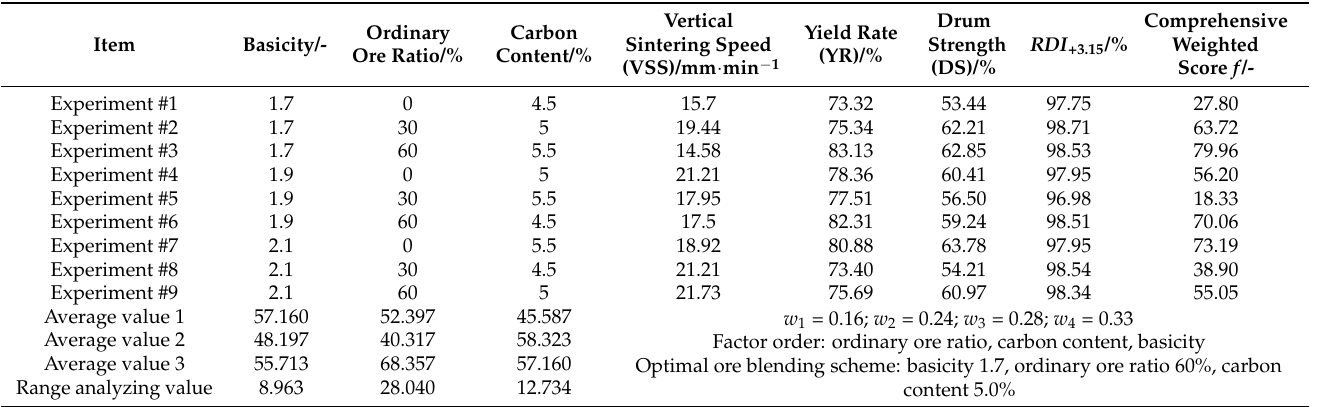
Table 12. Comprehensive weighted scoring